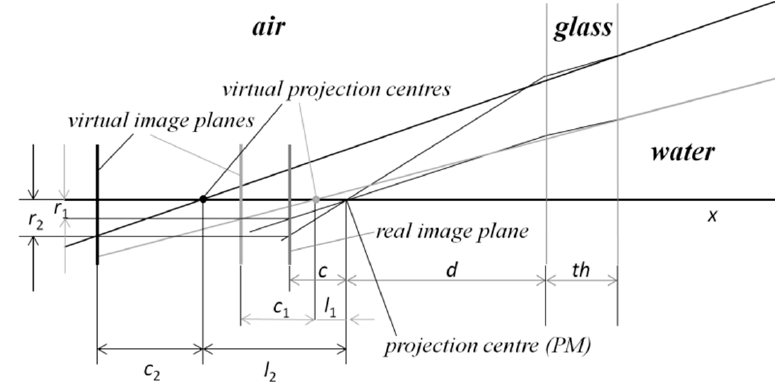
Figure 2. Ray geometry for two image points with radial distances r 1 and r 2 from the principal point using plane glasses (according to [44]).